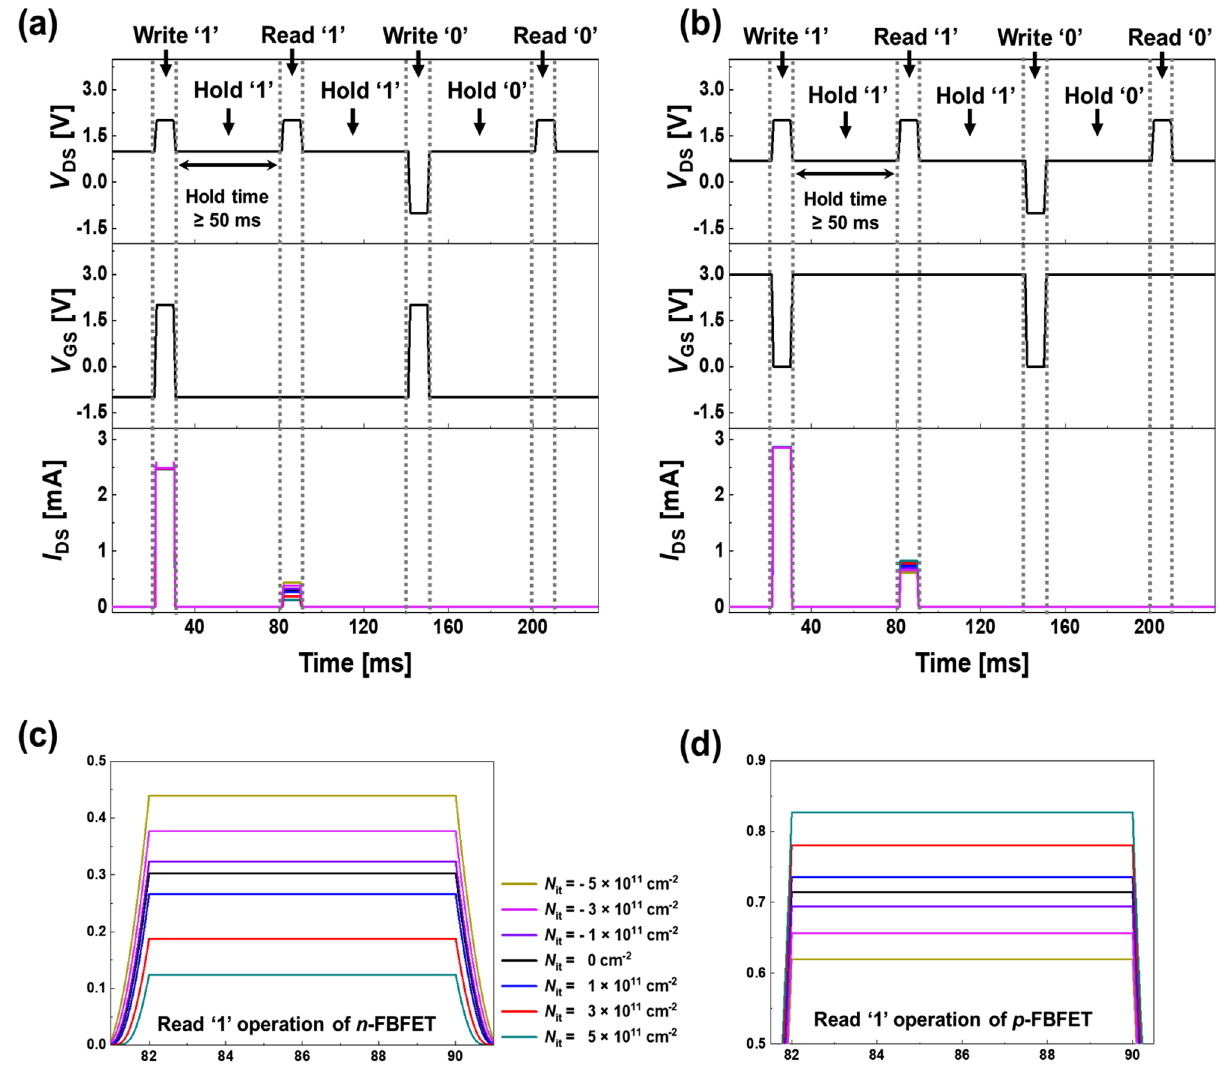
Figure 5. Timing diagrams for memory operation of ( a ) n - and ( b ) p -FBFETs including the ITCs. Enlarged view of output I DS based on different N it in ( c ) n - and ( d ) p -FBFETs during read ‘1’ operation.